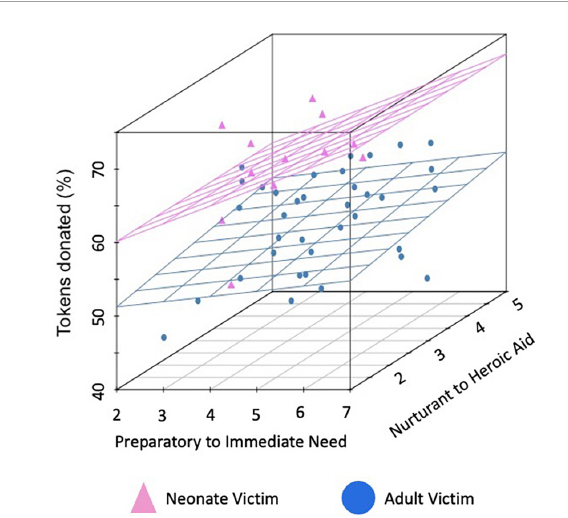
FIGURE2 Mean donations per charity by condition. Mean percent of tokens donated for each of the 48 charities. Charities that assisted neonates are represented in pink while those assisting adults are in blue. Data are plotted on the first axis by the degree participants (on average), rated the charity as sounding more like preparatory support provided at a distance (lower ratings) versus an immediate response in the moment (higher ratings) and on the second axis by the degree that it sounded more like nurturant (lower ratings) versus heroic (higher ratings) aid (both rated from 1 to 7).